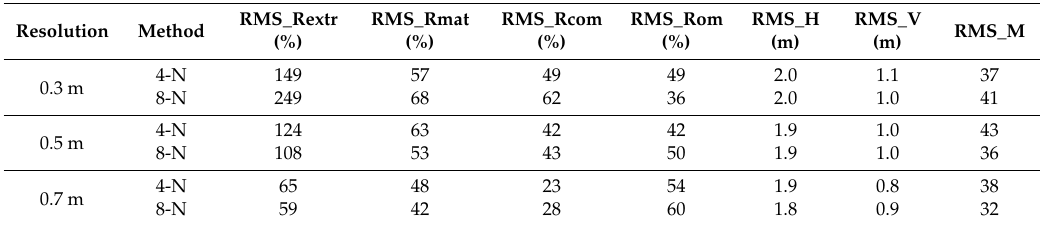
Table 5. Matching results of 4-N gradient orientation clustering (GOC) and 8-N GOC at different resolutions. 4-N GOC achieves more satisfactory results at 0.5 m